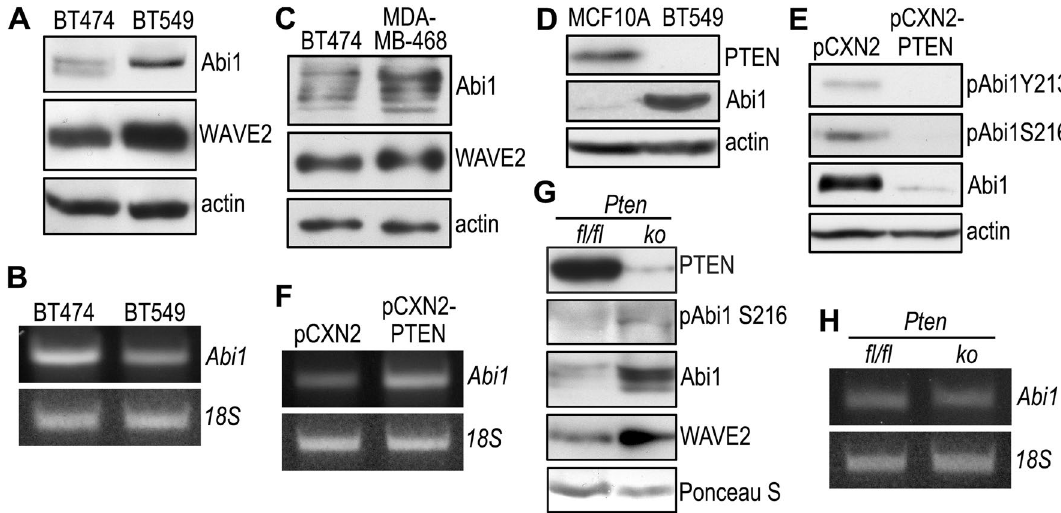
Figure 4. PTEN dephosphorylates Abi1 and negatively regulates its expression. ( A ) BT474 and BT549 cells were analyzed by immunoblotting for the expression of Abi1 and WAVE2. Actin served as a loading control. ( B ) Total RNA was extracted from BT474 and BT549 cells and analyzed by RT-PCR for Abi1. 18S served as a loading control. ( C ) Confluent BT474 and MDA-MB-468 cells were analyzed by immunoblotting for Abi1 and WAVE2. Actin served as a loading control. ( D ) Immunoblots show increased Abi1 expression in BT549 cells as compared with MCF-10A cells. ( E ) BT549 cells stably transfected with PTEN (pCXN2-PTEN) or the control vector (pCXN2) were subjected to immunoblot analysis. Actin served as a loading control. ( F ) PTEN-reconstituted and control BT549 cells were analyzed by RT-PCR for Abi1. 18S rRNA was used as a loading control. ( G ) Pten fl/fl ;UBC-Cre/ERT2 (Pten fl/fl as control) mice were injected peritoneally with 150 µg/kg tamoxifen for 5 days to disrupt the Pten gene. Two weeks after injection, mammary tissues were harvested for immunoblotting. Ponceau S stained proteins on the membrane served as loading controls. ko : Pten knockout, fl/ fl: Pten fl/fl . ( H ) Pten knockout and fl/fl control mammary tissues were analyzed by RT-PCR for Abi1. 18S served as a loading